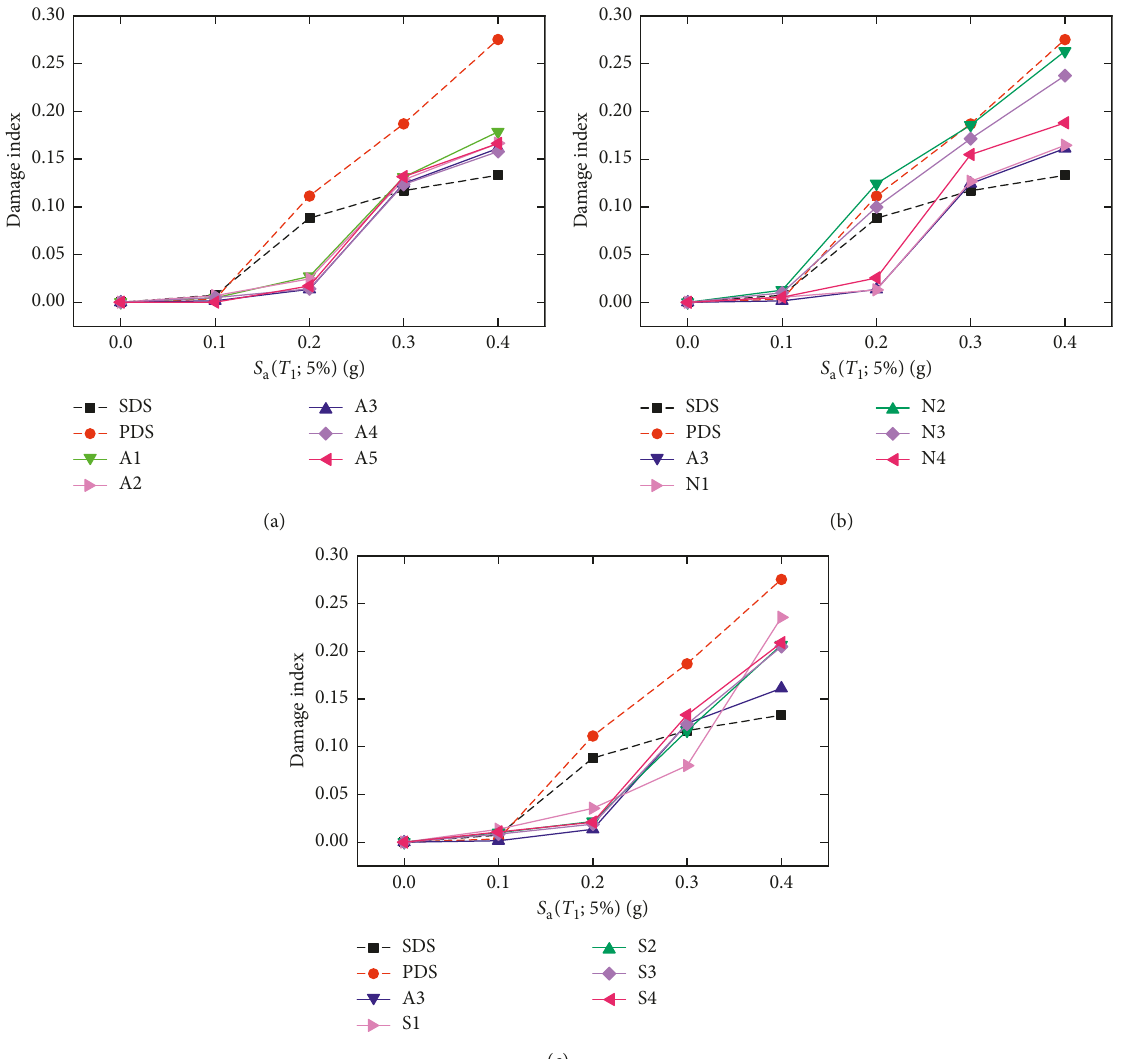
Figure 8: Damage index after seismic loads with different intensity